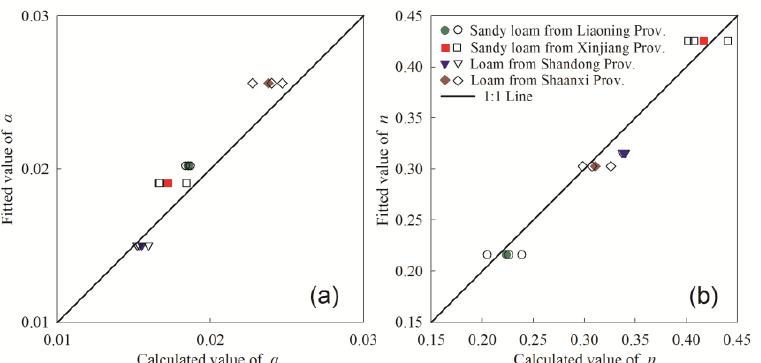
Figure 2. The fitted and calculated values the α and n parameters (hollow symbols represent the values of the three replicates, and the solid symbols represent the mean values of the three replicates). ( a ) Comparison of the fitted and calculated values of α ; ( b ) Comparison of the fitted and calculated values of n . Table 2. Parameter values for equations i and 1/ z f and I and z f .